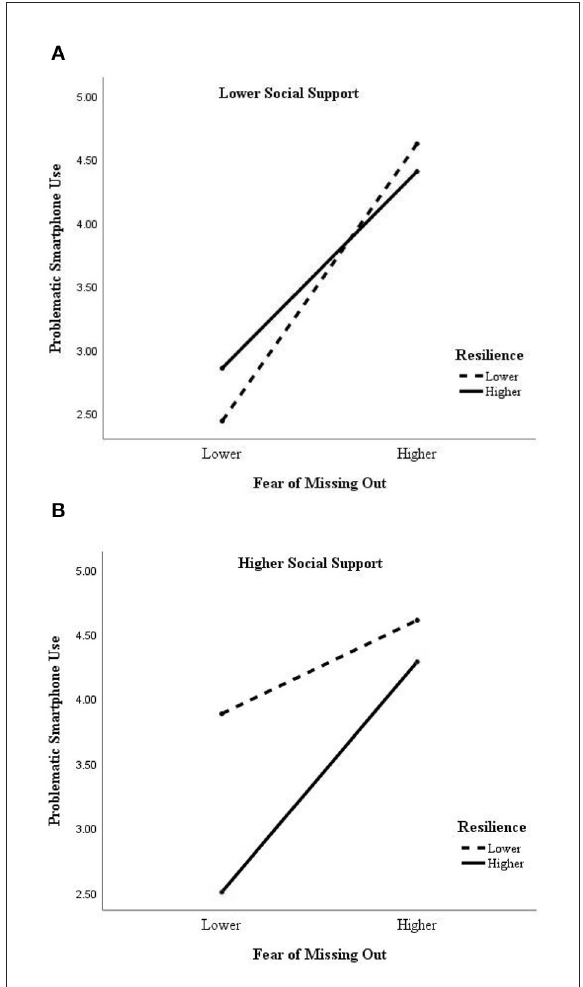
FIGURE2 (A) The moderating effect of resilience between FoMO and problematic smartphone use under lower social support. (B) The moderating effect of resilience between FoMO and problematic smartphone use under higher social